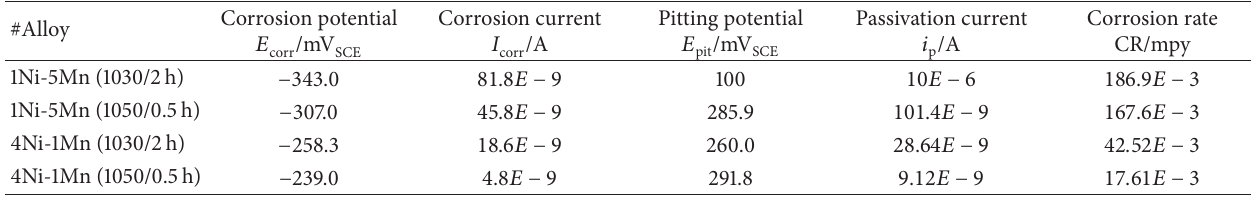
Table 2: Electrochemical corrosion data obtained when experiments were performed in 0.5 M NaCl solution at room temperature, 25 ∘ C.